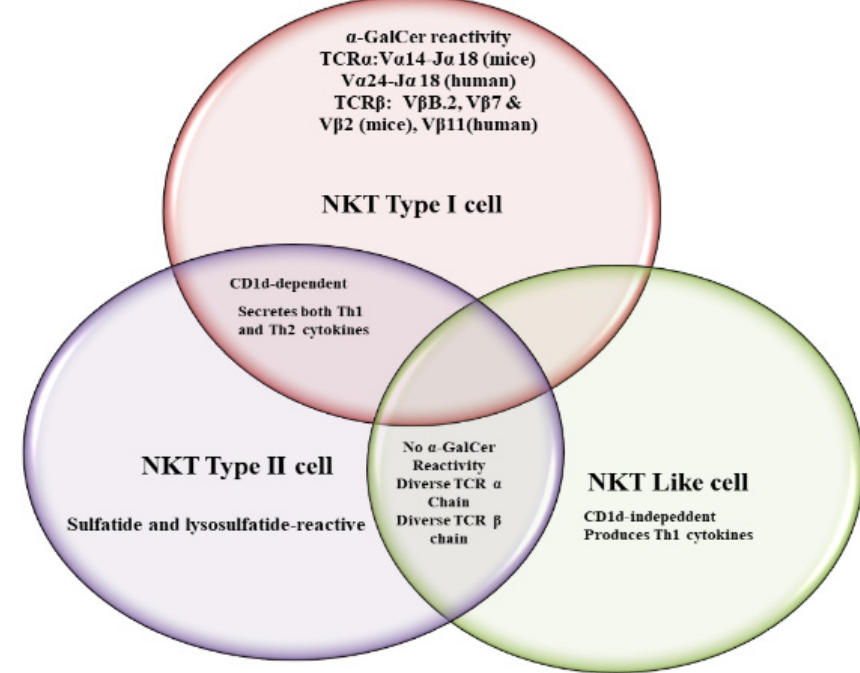
Figure 2. Similarities and differences between different types of NKT cells.